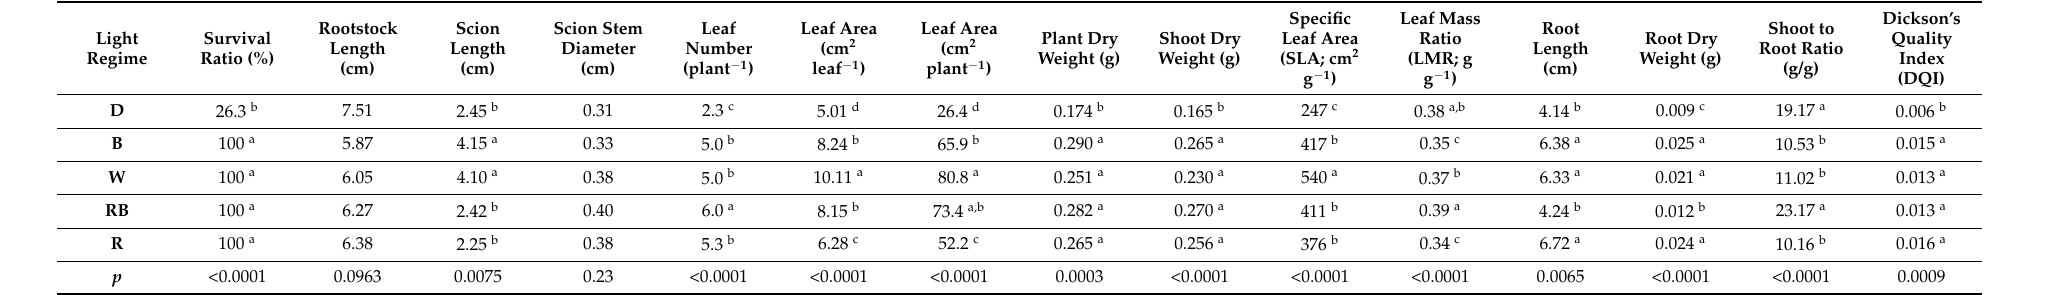
Table 1. Growth and morphology of grafted watermelon seedlings exposed for 12 days to either darkness (D) or different light quality regimes [blue (B), white (W), red and blue (RB), as well as red (R); see spectrum in Supplementary Figure S3]. Photosynthetic photon flux density was 20 ± 1 µ mol m − 2 s − 1 during the first 2 days, and 50 ± 1 µ mol m − 2 s − 1 during the following days. Nine plants per treatment were assessed. Means within a column followed by the same letters are not significantly different at p ≤ 0.05 according to Duncan’s multiple range